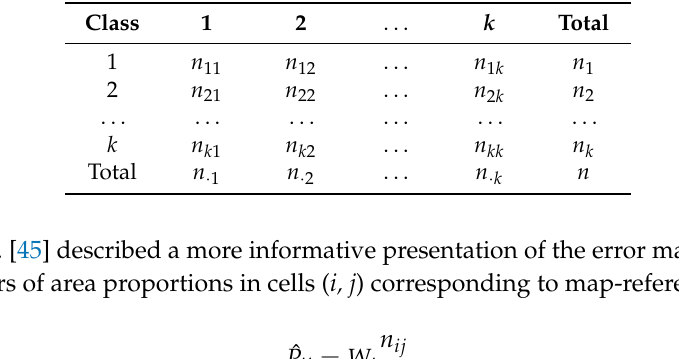
Table 3. Error matrix of sample counts, n ij .